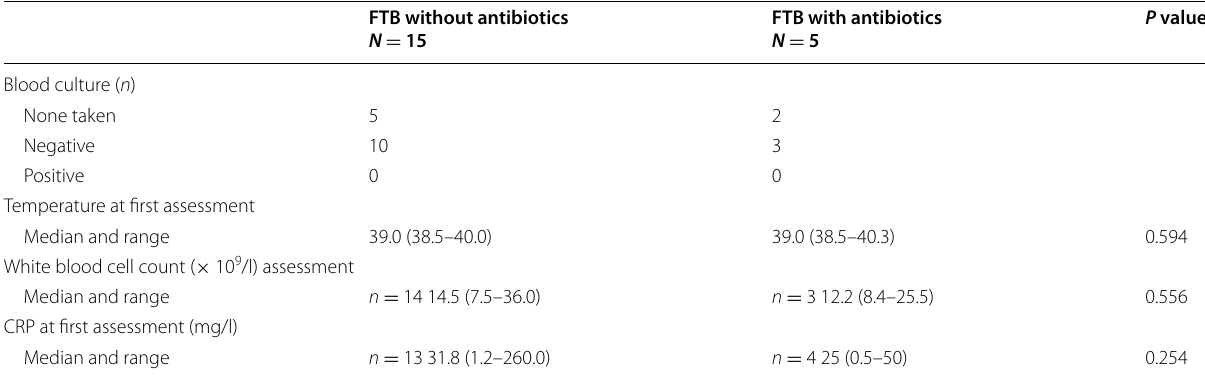
Table 3 Analyses of various characteristics for children with a fever of 38.5 °C or higher